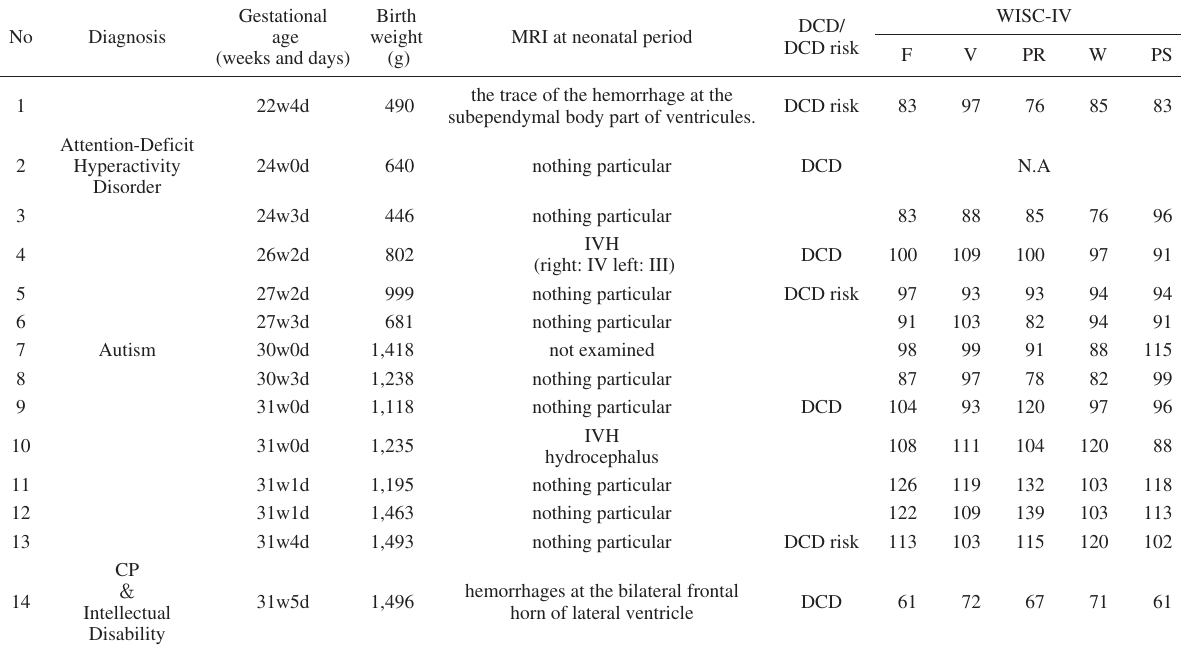
CP, cerebral palsy; IVH, intraventricular hemorrhage; DCD, developmental coordination disorder; WISC-IV, Wechsler intelligence scale for chil- dren-fourth edition; N.A, not assessed; F, final intelligent quotient; V, verbal comprehension index (VCI); PR, perceptional reasoning index (PRI); W, working memory index (WMI); PS, processing speed